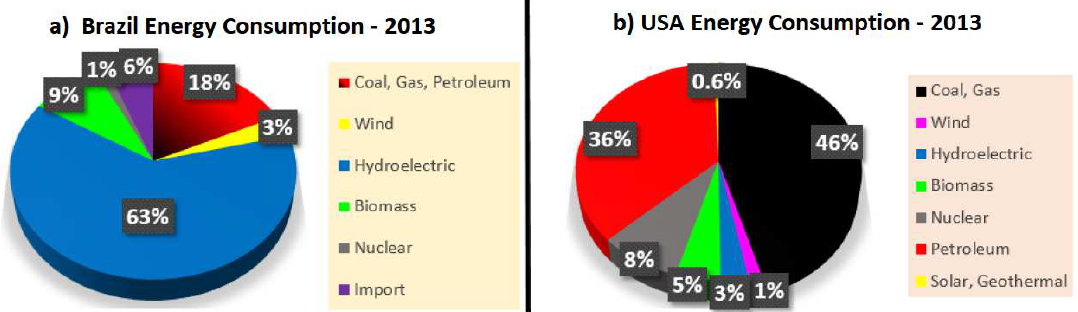
Figure 5. Energy Consumption: Brazil vs.